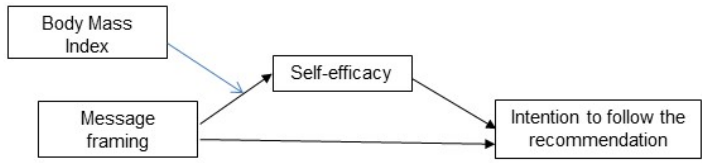
Figure 1. Research